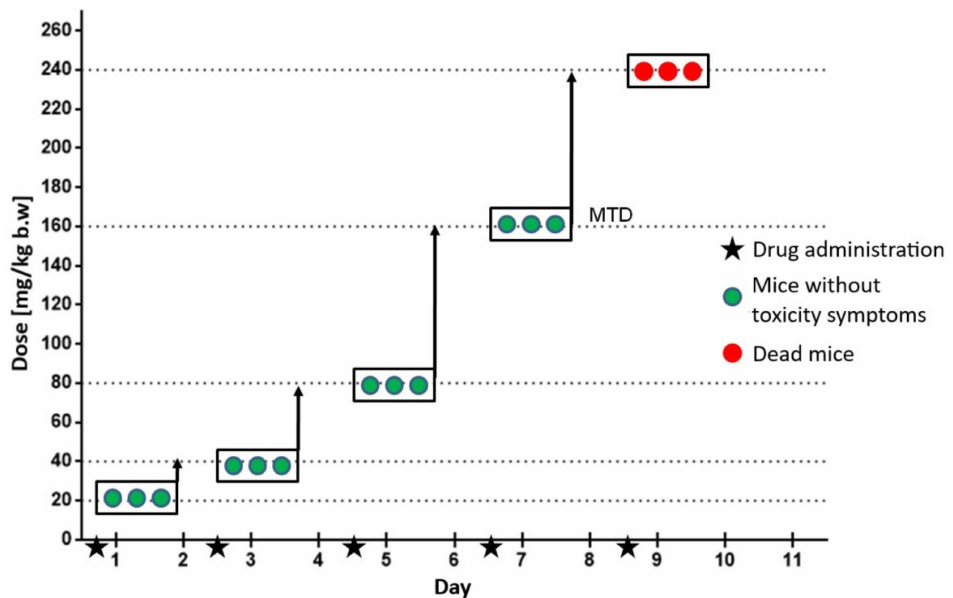
Figure 9. Diagram showing the determination of the maximum tolerated dose (MTD). Each box represents a group of 3 mice that were given the tested compound at the specific dose. After each administration, the mice were observed for 48